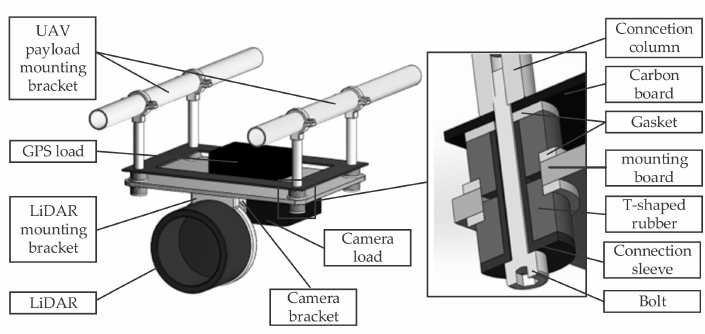
Figure 9. Radar installation damping platform and damper structure.